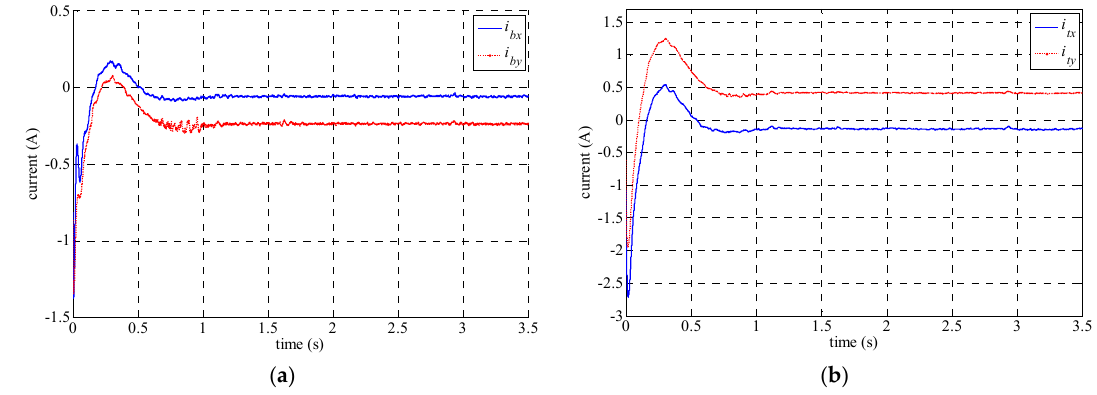
i and i ; and ( b ) control currents by bx